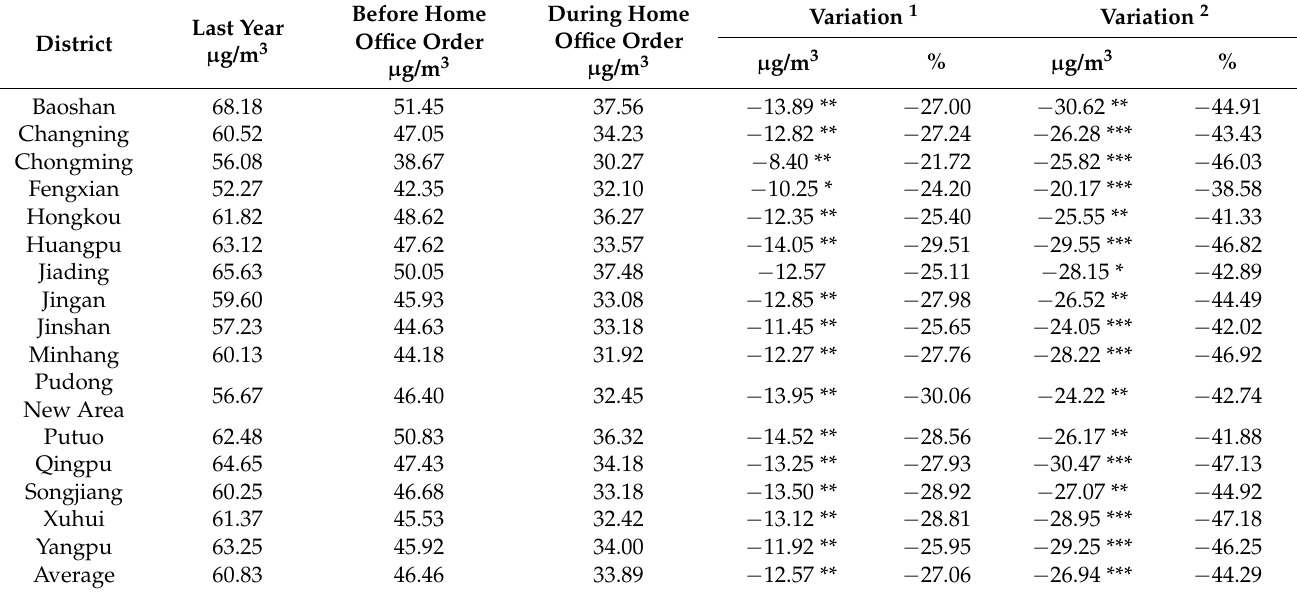
Table 1. Variation of daily PM 10 concentrations after implementing the home office order for 60